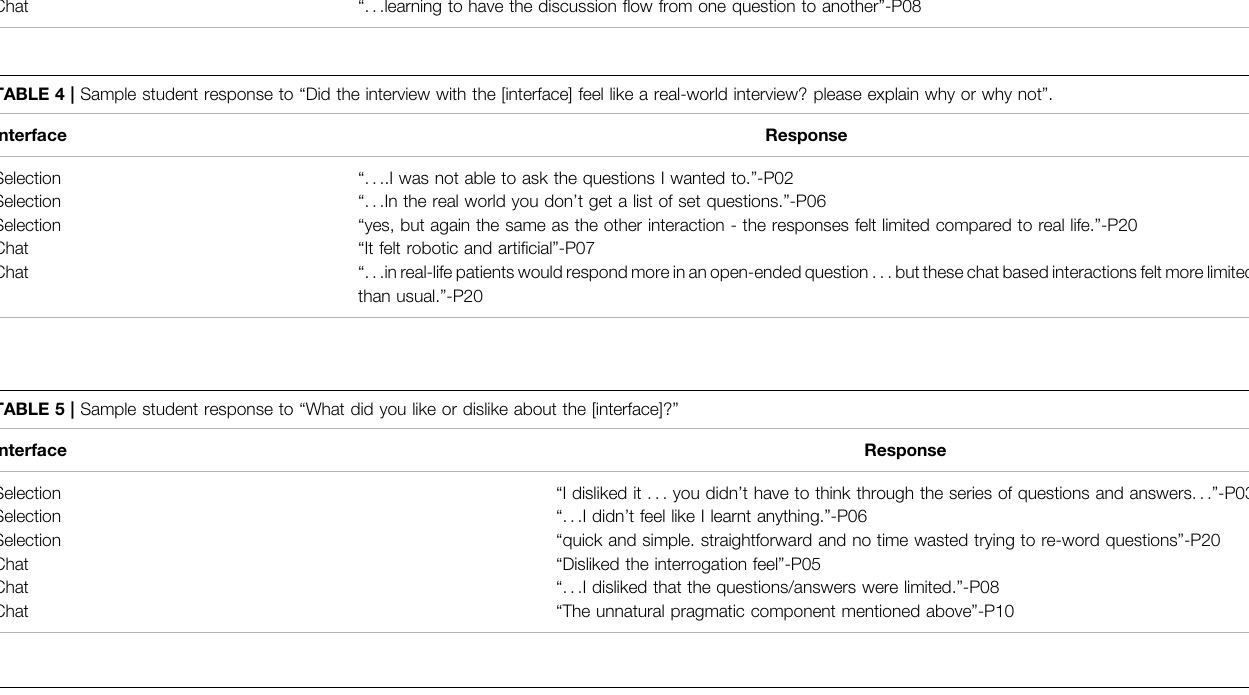
TABLE6| Themeans,standarddeviations,andMann-Whitney U testresultsforthethreemessageproductiontranscriptsatInterview1andInterview3.Metricsarede fi ned in Section 4.2.2 . Interview